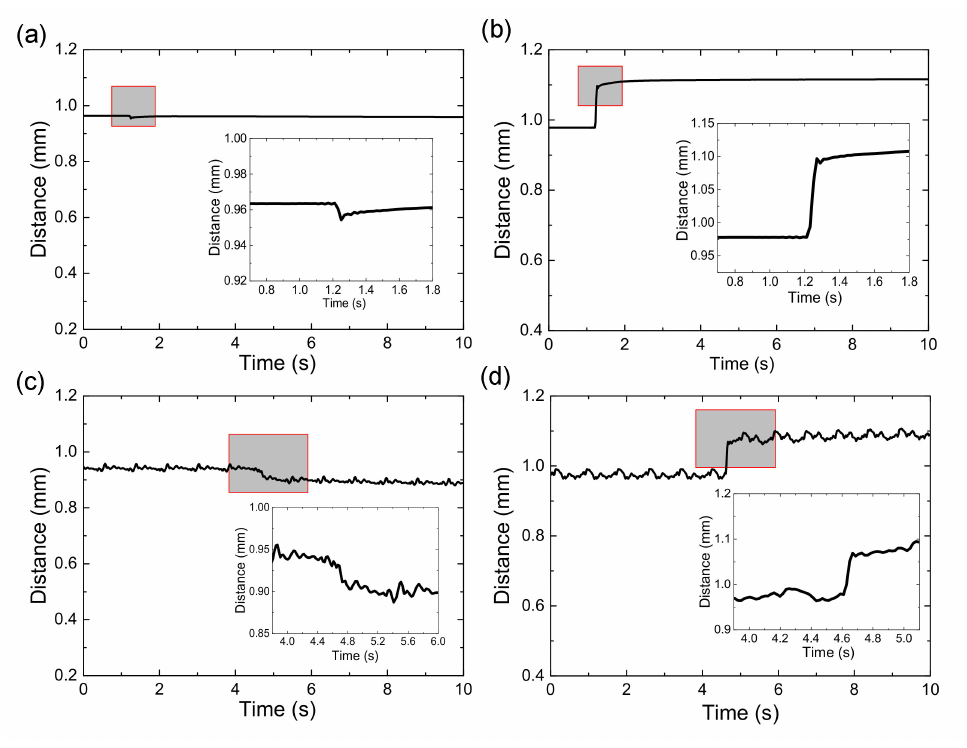
Figure 5. Vertical position distance change of both sides of the test bearing: ( a ) left side—0 r/min; ( b ) right side—0 r/min; ( c ) left side—50 r/min; ( d ) right side—50 r/min.